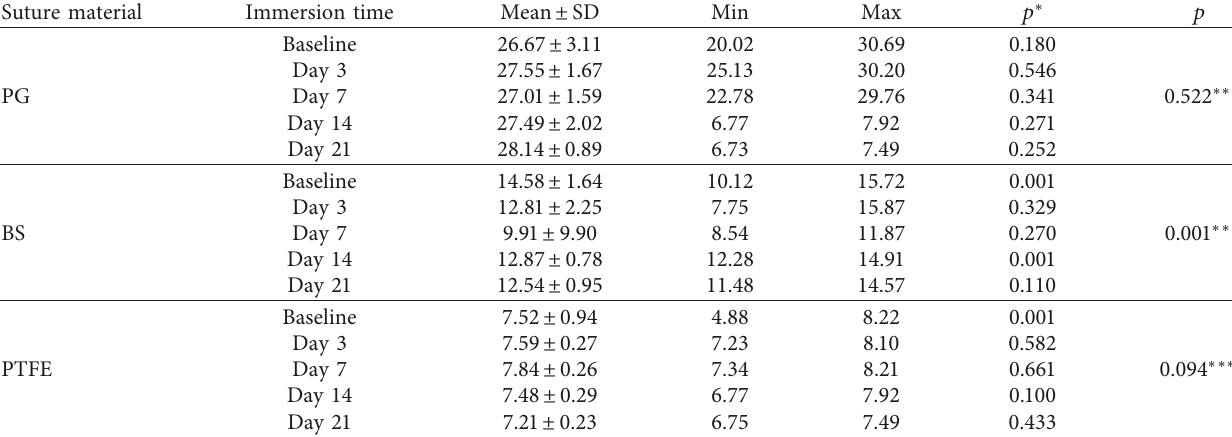
Table 2: Tensile strength of various absorbable and nonabsorbable sutures according to immersion time in synthetic saliva. Suture material